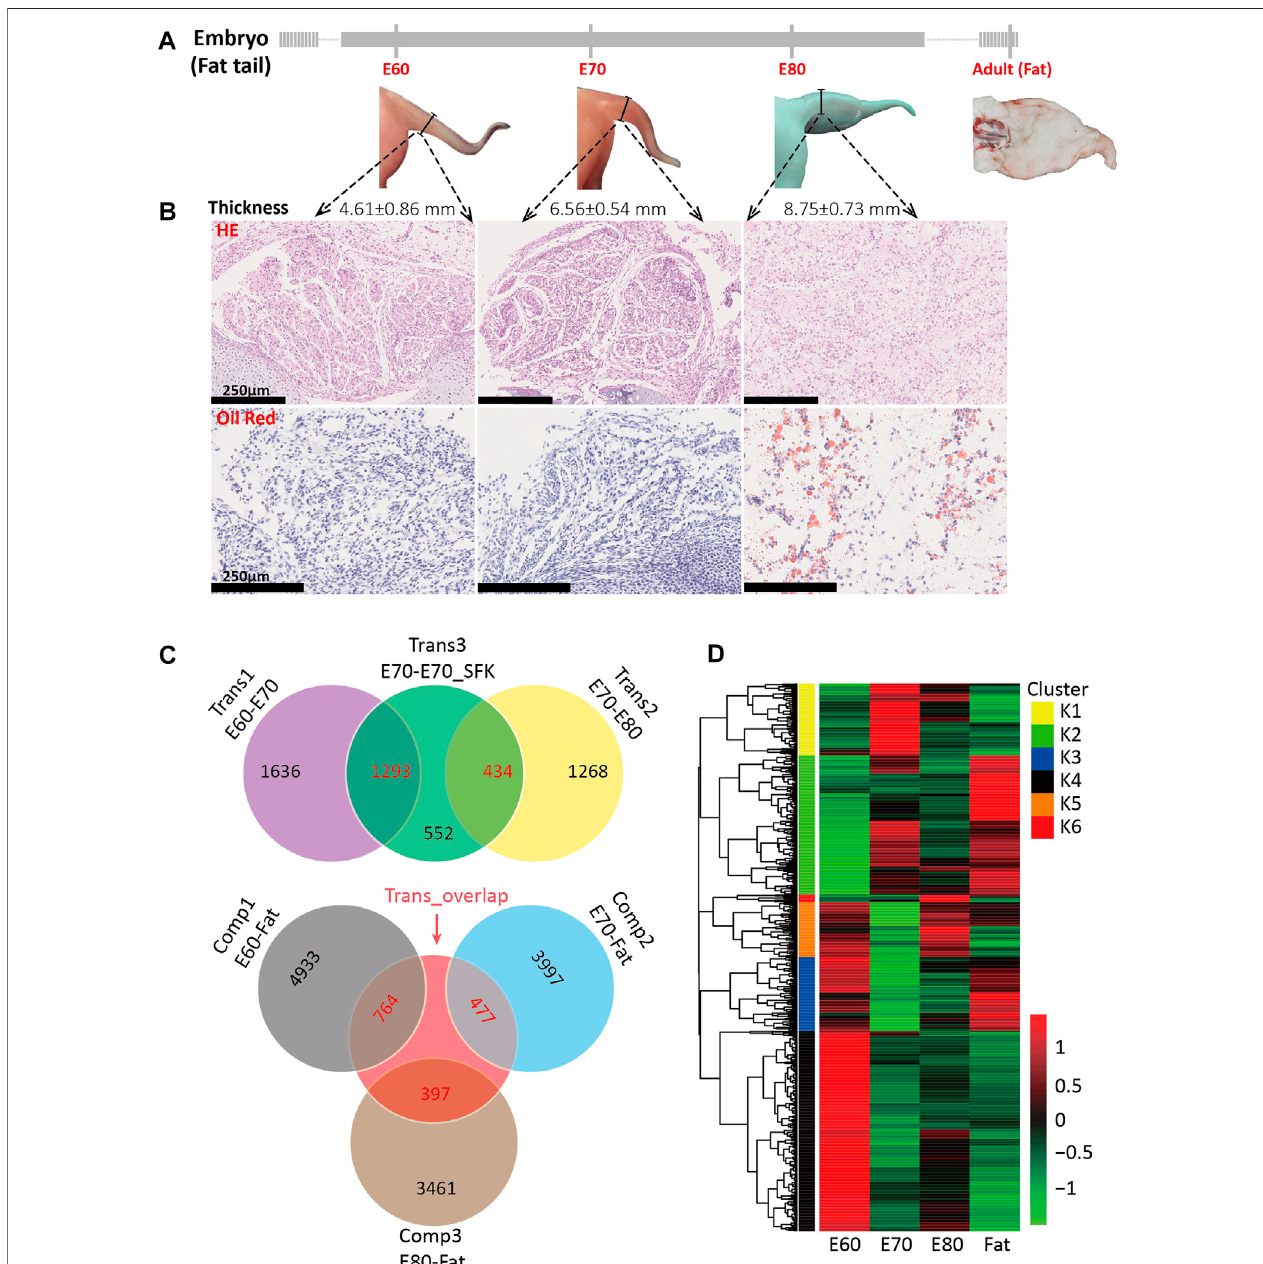
FIGURE 1 | Tail morphogenesis and schematic of DEG comparisons among experimental groups. (A) Morphology of tail at four different stages, including E60, E70, E80 and adult, also showing corresponding tail thickness. (B) Hematoxylin and eosin (HE) and oil red staining for fat tail tissues at E60, E70, and E80. (C) A Venn diagramforthethreetransitiongroupsandthethreecomparisongroupsbasedonthedetectedDEGs,includingtheDEGsbetweenE60andE70(trans1),betweenE70 and E80 (trans2), between E70 and E70_SFK (trans3), between E60 and Fat (comp1), between E70 and Fat (comp2), and between E80 and Fat (comp3). The number of DEGs shared between two groups is shown in red and the number of unique DEGs is shown in black. (D) A heatmap for 1,058 candidate genes based on expressionattheE60,E70,E80andFatstages.Thesegenesoverlappedbetweentrans3andtheother fi vegroupsindividuallyandcanbedividedintosixclustersbased on the Calinsky criterion.